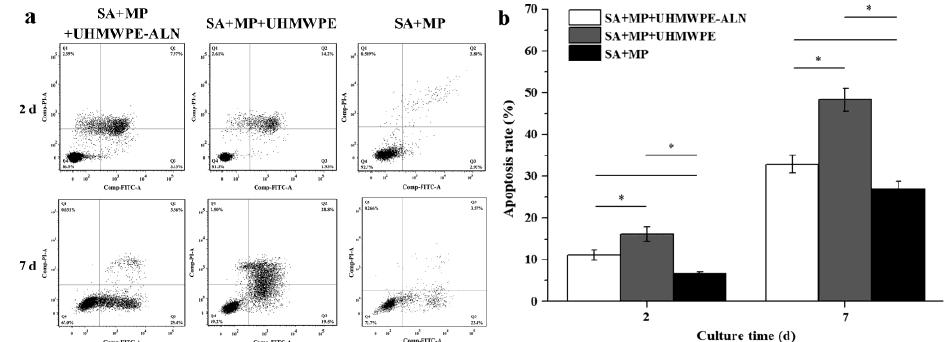
Figure 2. Effects of critical-sized UHMWPE-ALN wear particles on the apoptosis of macrophages in cell reactors after incubated for 2 and 7 d. ( a ): The representative images of flow cytometry. Q1 (Annexin V-FITC-/PI+): percentage of necrosis cells; Q2 (Annexin V-FITC+/PI+): percentage of late apoptosis cells; Q3 (Annexin V-FITC+/PI-): percentage of early apoptosis cells; and Q4 (Annexin V-FITC-/PI-): percentage of viable cells. ( b ): Quantitative apoptosis rates of macrophages by flow cytometry ( n = 3, * p <